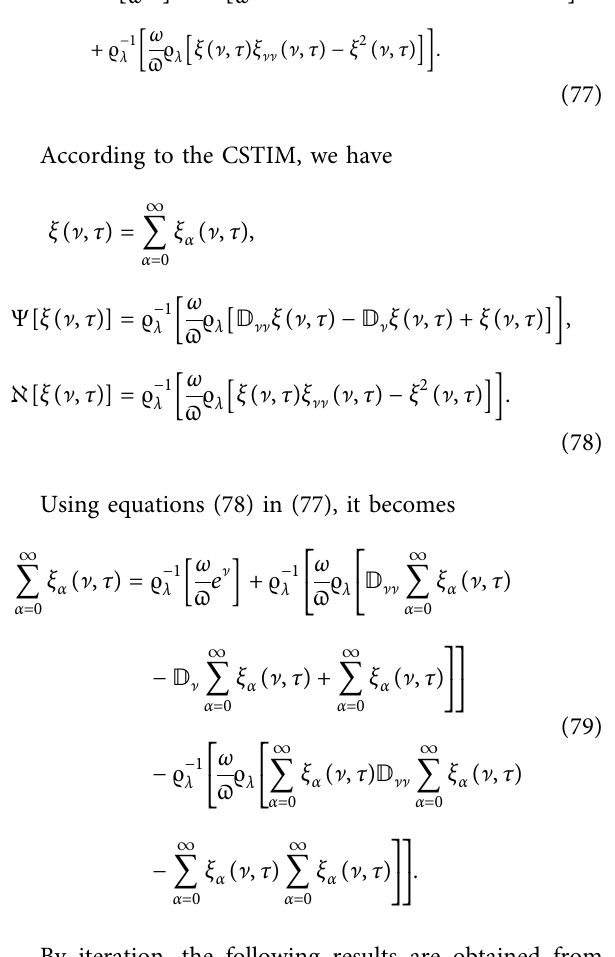
Table 3: The absolute errors for Example 3 at λ